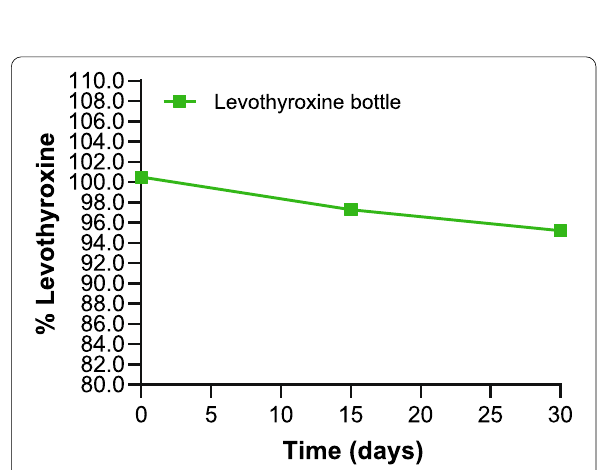
Fig. 5 Potency of levothyroxine during 30-day 28 °C/65% RH: full exposure study. Abbreviation: RH, relative